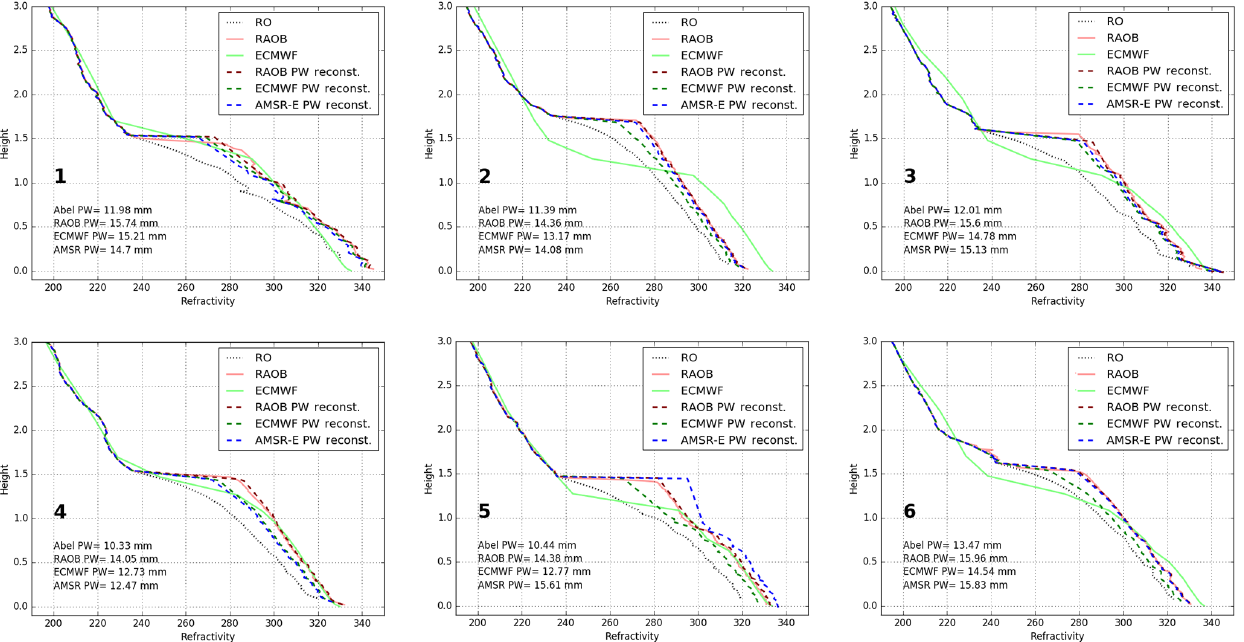
Figure 5. Refractivity profiles from simulated RO, radiosonde measurements, ECMWF analysis, and reconstruction using RAOB and ECMWF-computed PW and AMSR-E retrievals for the six collocated cases. The case number is found on the left side of each panel. It can be observed that the ducting layer height in the ECMWF model is mostly lower than the one measured by radiosondes. The RO optimal estimation results, which correspond to different PW sources, can correct the N -bias with a higher amount of water vapor content measured by other